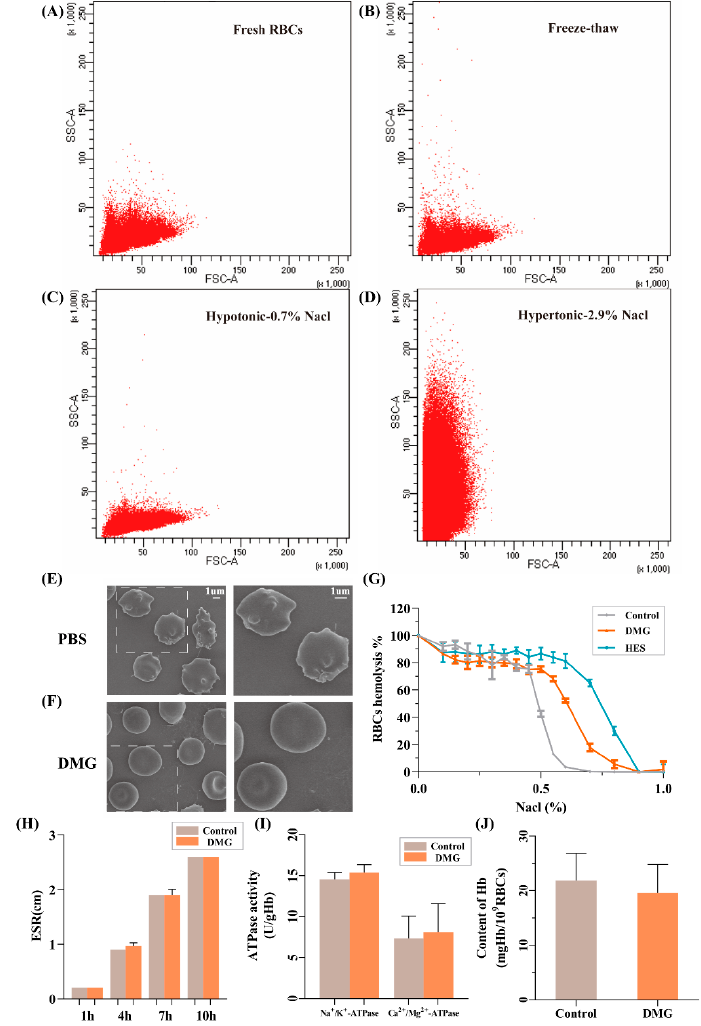
Figure 6. The properties of thawed RBCs after cryopreservation. Flow cytometry plots showed the forward scatter and side scatter of fresh RBCs ( A ) and post-freeze–thaw RBCs in DMG solution ( B ). For ( A , B ), RBCs were maintained in an isotonic environment so that they neither shrank nor swelled. For comparison, fresh RBCs placed in hypotonic 0.7% NaCl swelled due to the intake of water ( C ). In hypertonic 2.9% NaCl, fresh RBCs shrank due to loss of water ( D ). The representative SEM images of thawed RBCs incubated in PBS ( E ) and DMG ( F ). Osmotic fragility curves ( G ) of RBCs at different solutions. The ESR ( H ), ATPase activities ( I ), and content of Hb ( J ) of thawed RBCs in the control group and DMG group. The concentrations of DMG and HES were 4% and 13%, respectively. The fresh RBCs without cryopreservation were selected as the control group. Data are presented as the mean ± SD. Erythrocyte sedimentation rate (ESR), hemoglobin (Hb). ESR, one of the vital considerations of blood rheology, refers to the sedimentation velocity of RBCs in the blood. It fluctuates within a narrow range in normal RBCs and in- difference in ESR between the DMG group and the control group at 1 h, 4 h, 7 h, and 10 h. Na + /K + -ATPase and Ca 2+ /Mg 2+ -ATPase are two ATP-hydrolyzing enzymes that help